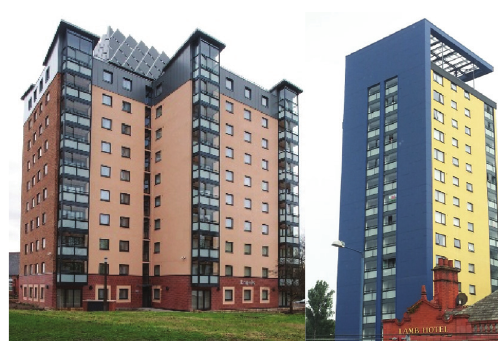
Figure 2: City West Housing Trust high-rise blocks after works. Source :